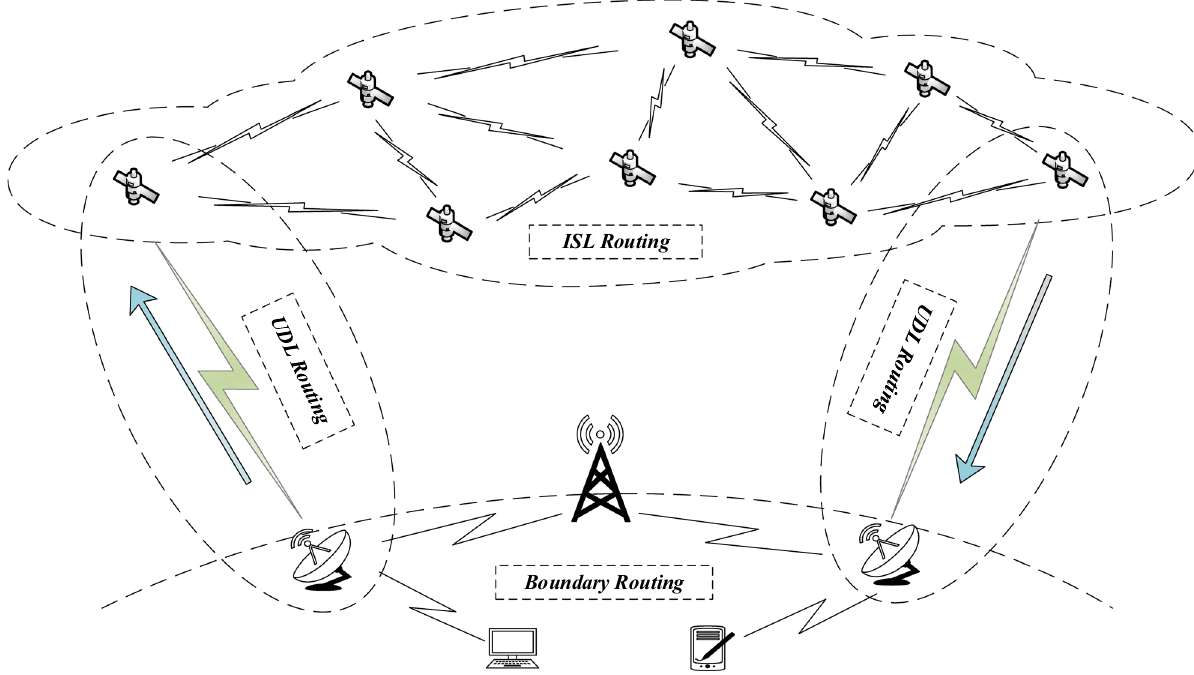
Figure 2. Under the perspective of routing domains, the routing of SINs can be divided into three types: UP and Down Links (UDLs) routing, boundary routing, and Inter-Satellite Links (ISLs) routing